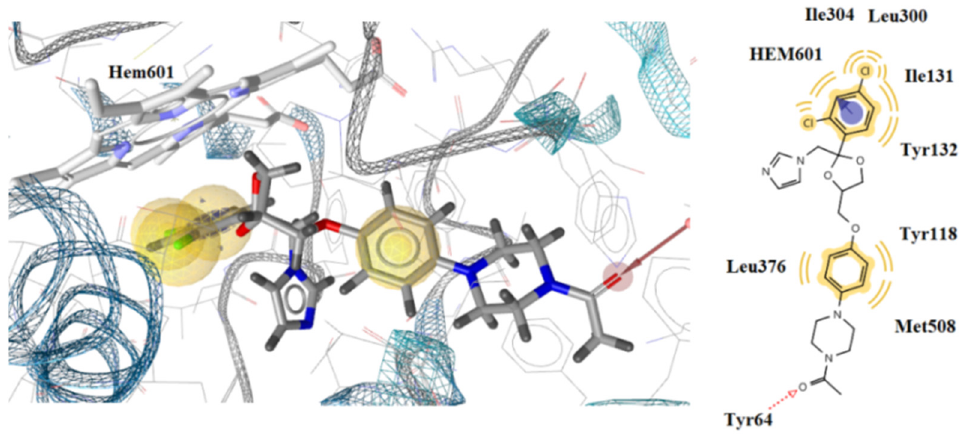
Figure 6. Docked conformation of ketoconazole in lanosterol 14 α -demethylase of C . albicans (CYP51 ca ).